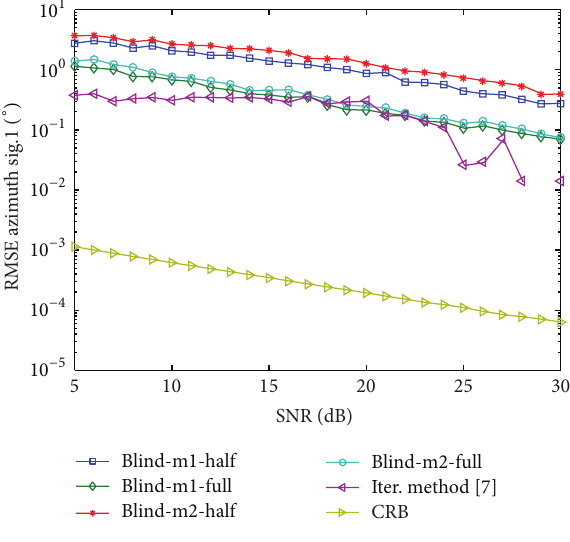
Figure 5: RMSE versus SNR for signal 1.